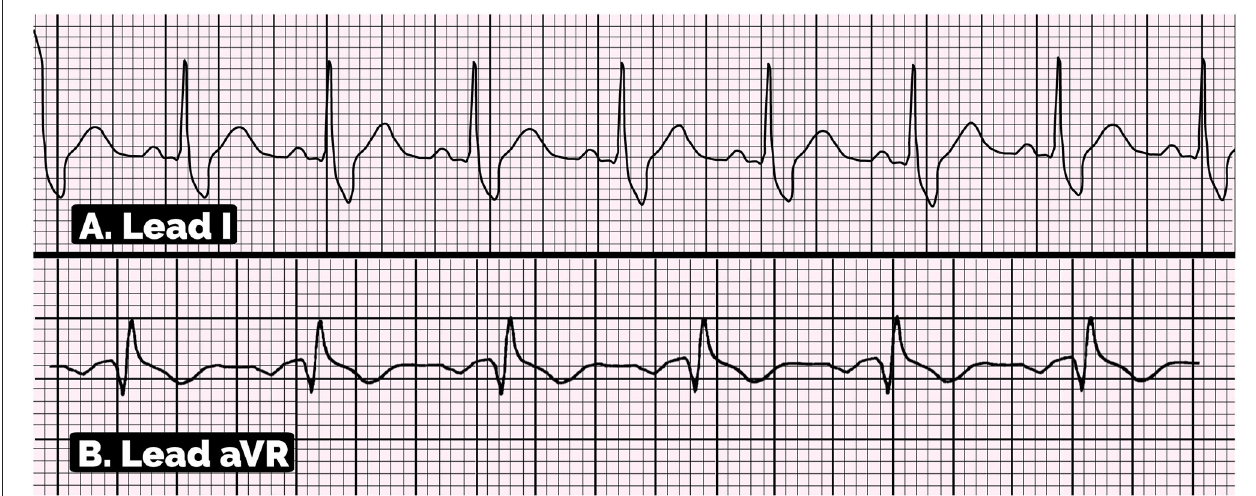
FIGURE 5 | Electrocardiographic pattern of positive aVR sign and large S wave in lead I. (A) This ECG showed S-wave amplitude ≥ 0.1mV and duration > 40ms in lead I, suggesting the large S wave in lead I. (B) This ECG showed the positive aVR sign with the amplitude of R wave in aVR lead is ≥ 0.3mV and R/q ratio is ≥ 0.7.